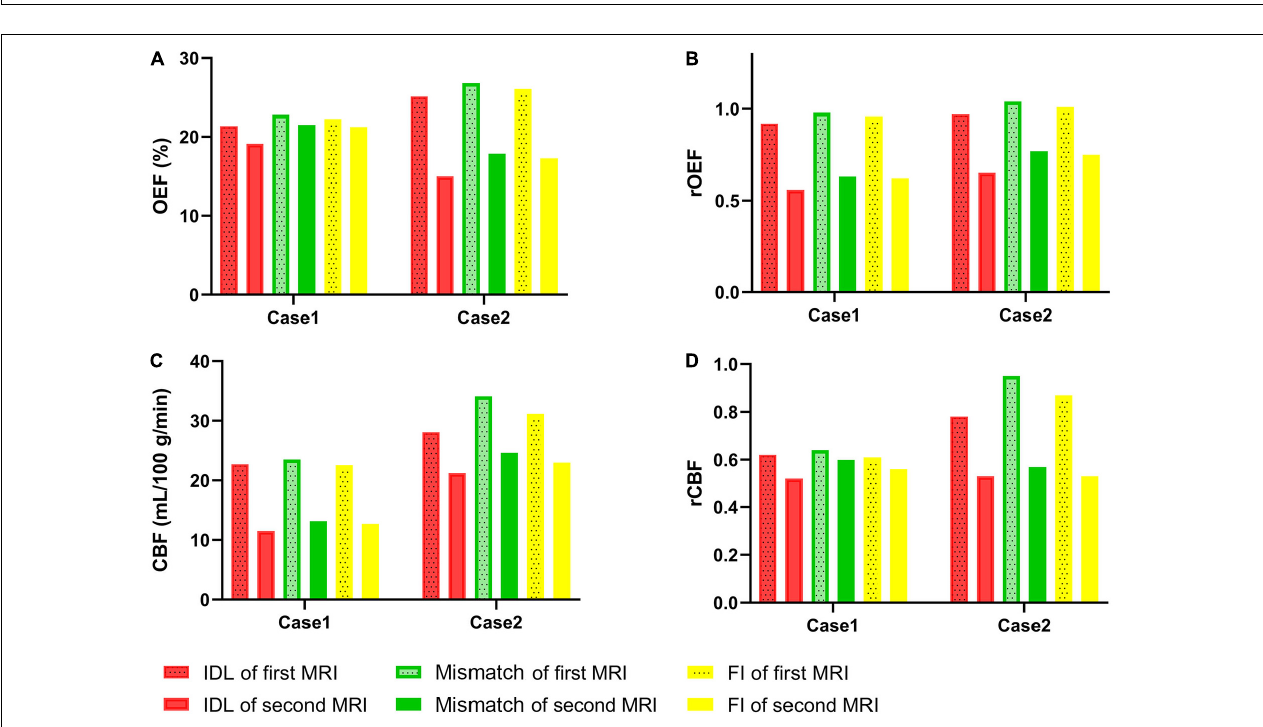
FIGURE 6 | Parameters of IDL, mismatch, and FI between the longitudinal MRI scans in two patients with enlarged lesion volume. (A) OEF. (B) rOEF. (C) CBF. (D) rCBF. OEF, oxygen extraction fraction; rOEF, relative OEF; CBF, cerebral blood flow; rCBF, relative CBF; IDL, initial diffusion lesion; FI, final infarct.